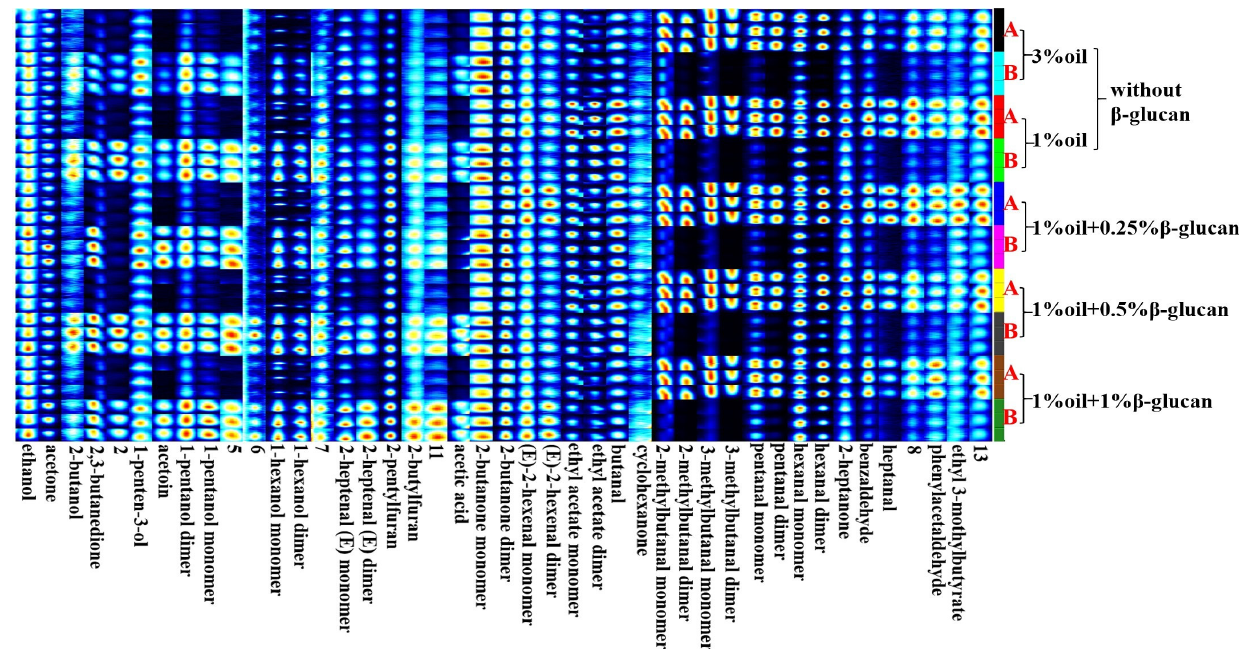
Figure 6. The fingerprints of low-fat pea-protein-based yogurt with different levels of oat β -glucan before and after fermentation: A and B represent the samples with or without fermentation, respectively.